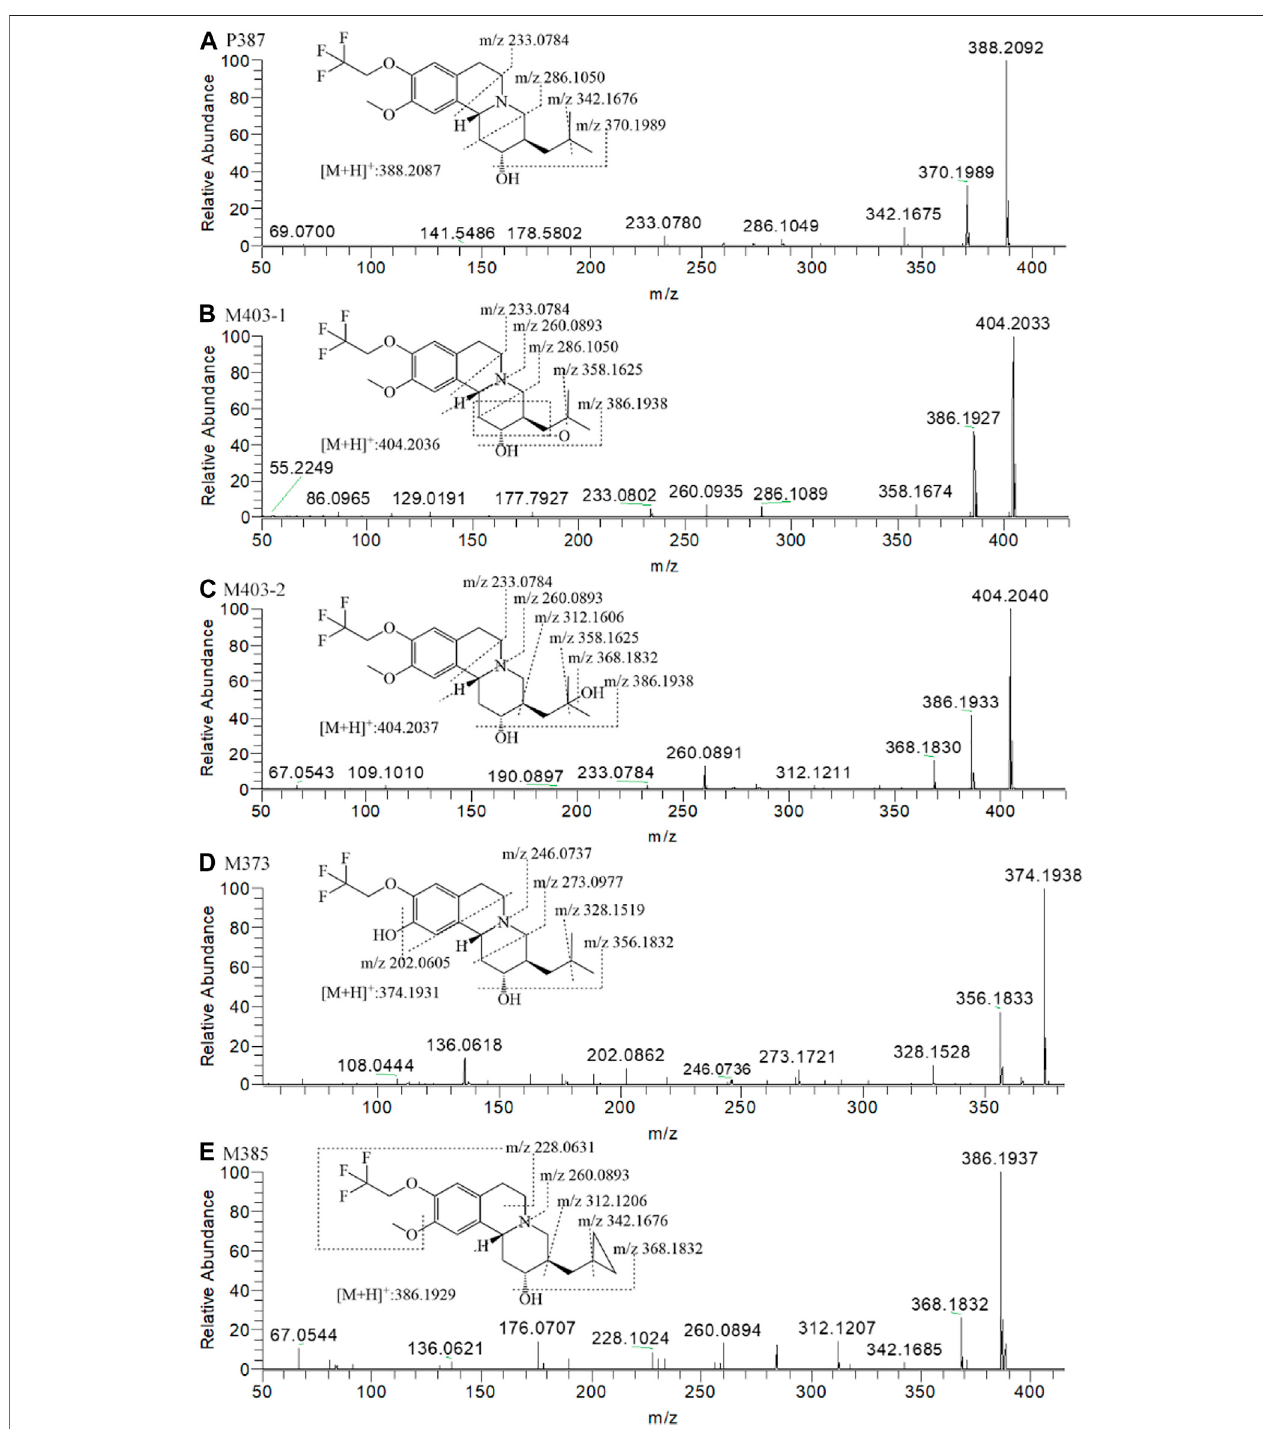
FIGURE6| TheMS 2 spectraand proposed fragmentation pathways ofthemetabolitesof(+)-9-tri fl uoroethoxy- α -dihydrotetrabenazine[(+)-13e]after incubation in human liver microsomes.